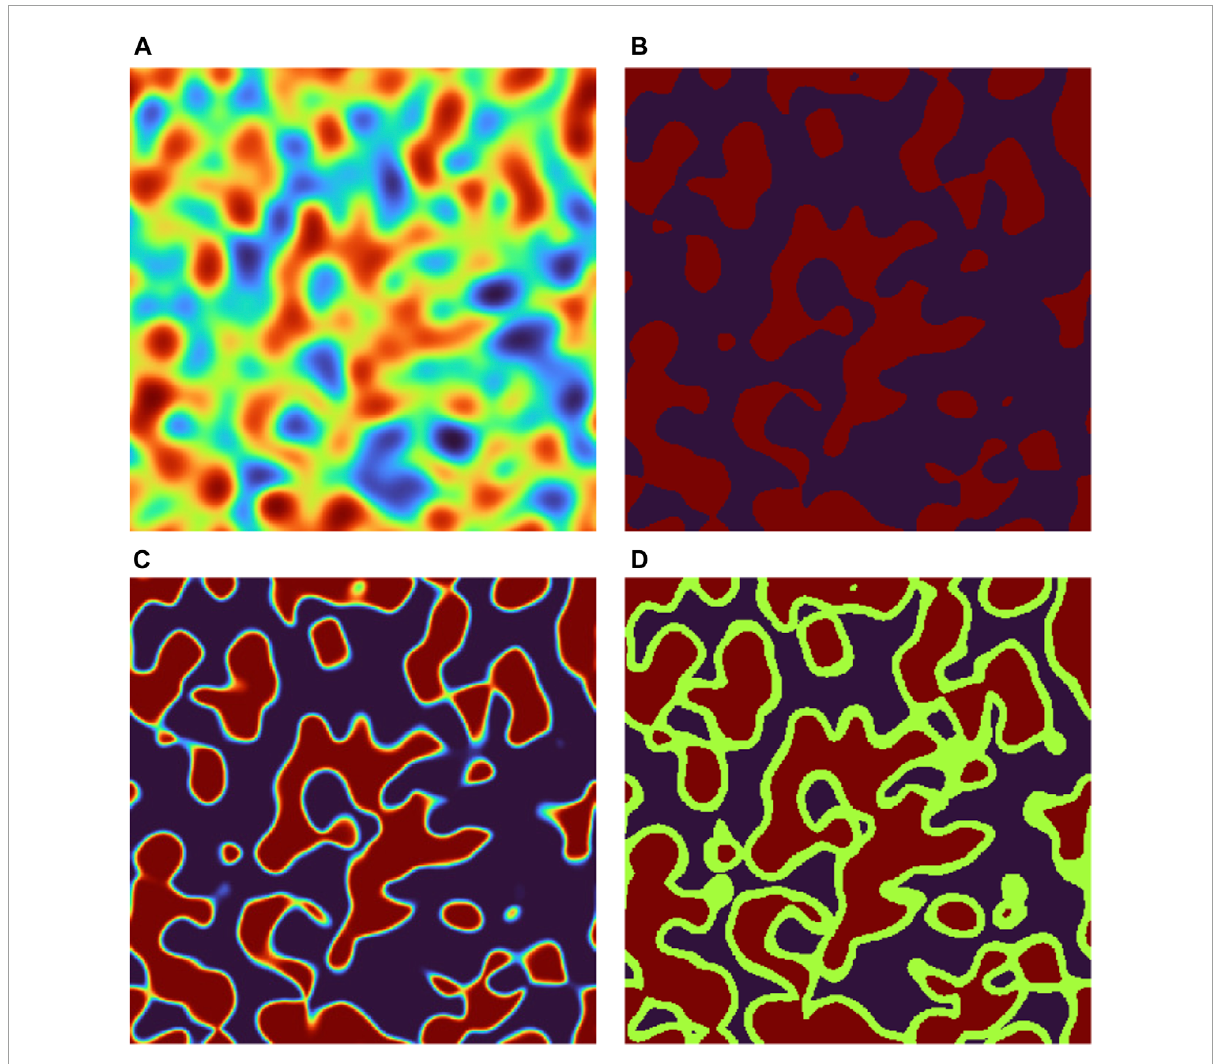
FIGURE 1 Illustration of a single 2D slice of a three-phase model with a = 4 nm, ϵ = 0 . 60, and ν = 0 . 50. In (A) , the GRF is shown (arbitrary intensity scale). In (B) , a binary structure is shown, obtained from (A) by thresholding at the quantile ϵ . In (C) , a smooth structure is shown, obtained from (B) by smoothing with a 3D Gaussian filter. In (D) , the final electron density is shown, obtained from (C) by thresholding at the quantiles ϵ ( 1 − ν ) and ϵ